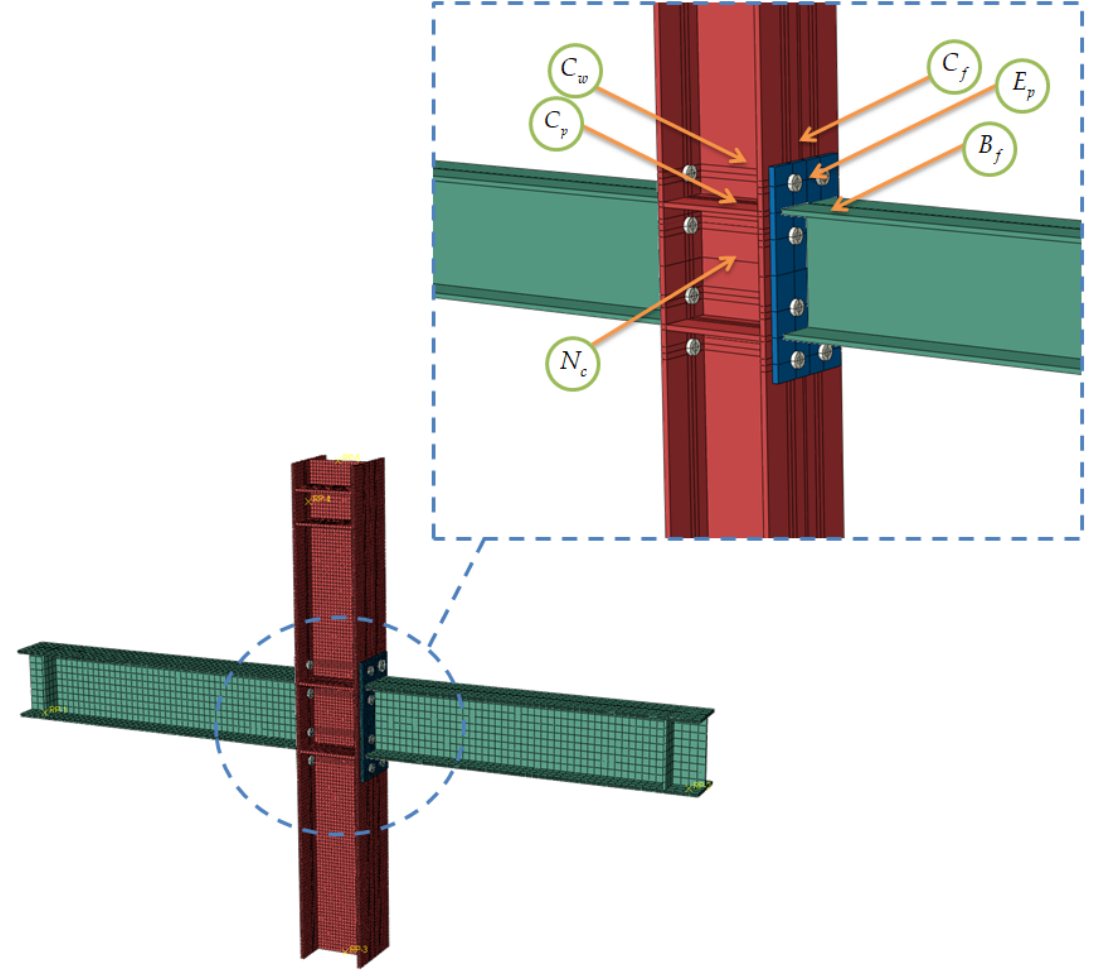
Figure 2. Specified points of the finite element model.